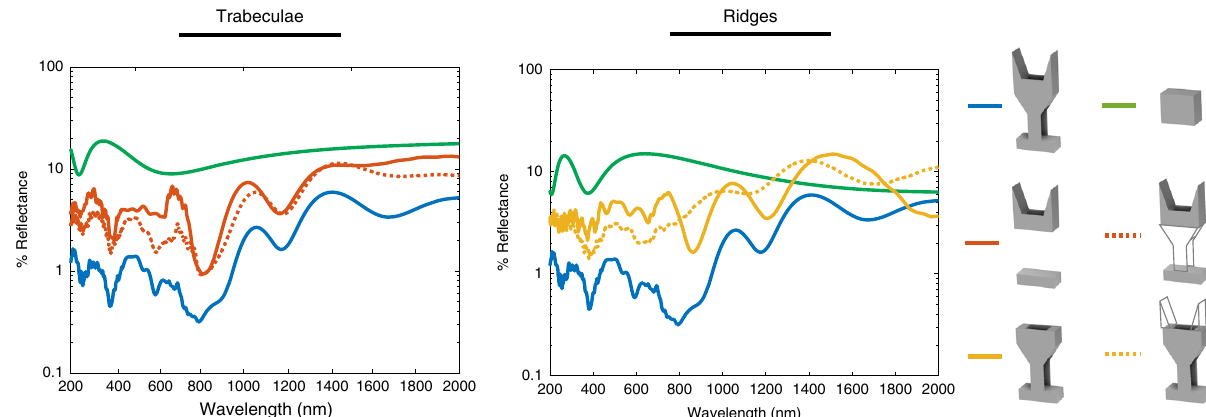
Fig. 4 Decoupling the effects of structure and absorption on scale re fl ectance. (Left) Comparing simulations of scales with the trabeculae removed versus scales with non-absorbing trabeculae. Adding non-absorbing trabeculae to a scale that has none decreased re fl ectance between 5 and 70% in the visible range (350 – 700 nm). (Right) Comparing simulations of scales with the ridges removed versus scales with non-absorbing ridges. Non-absorbing ridges contribute a reduction in re fl ectance between 14 and 58% in the visible range (350 – 700 nm). For both the ridges and the trabeculae, the structure contributes more to reduced re fl ectance in the visible